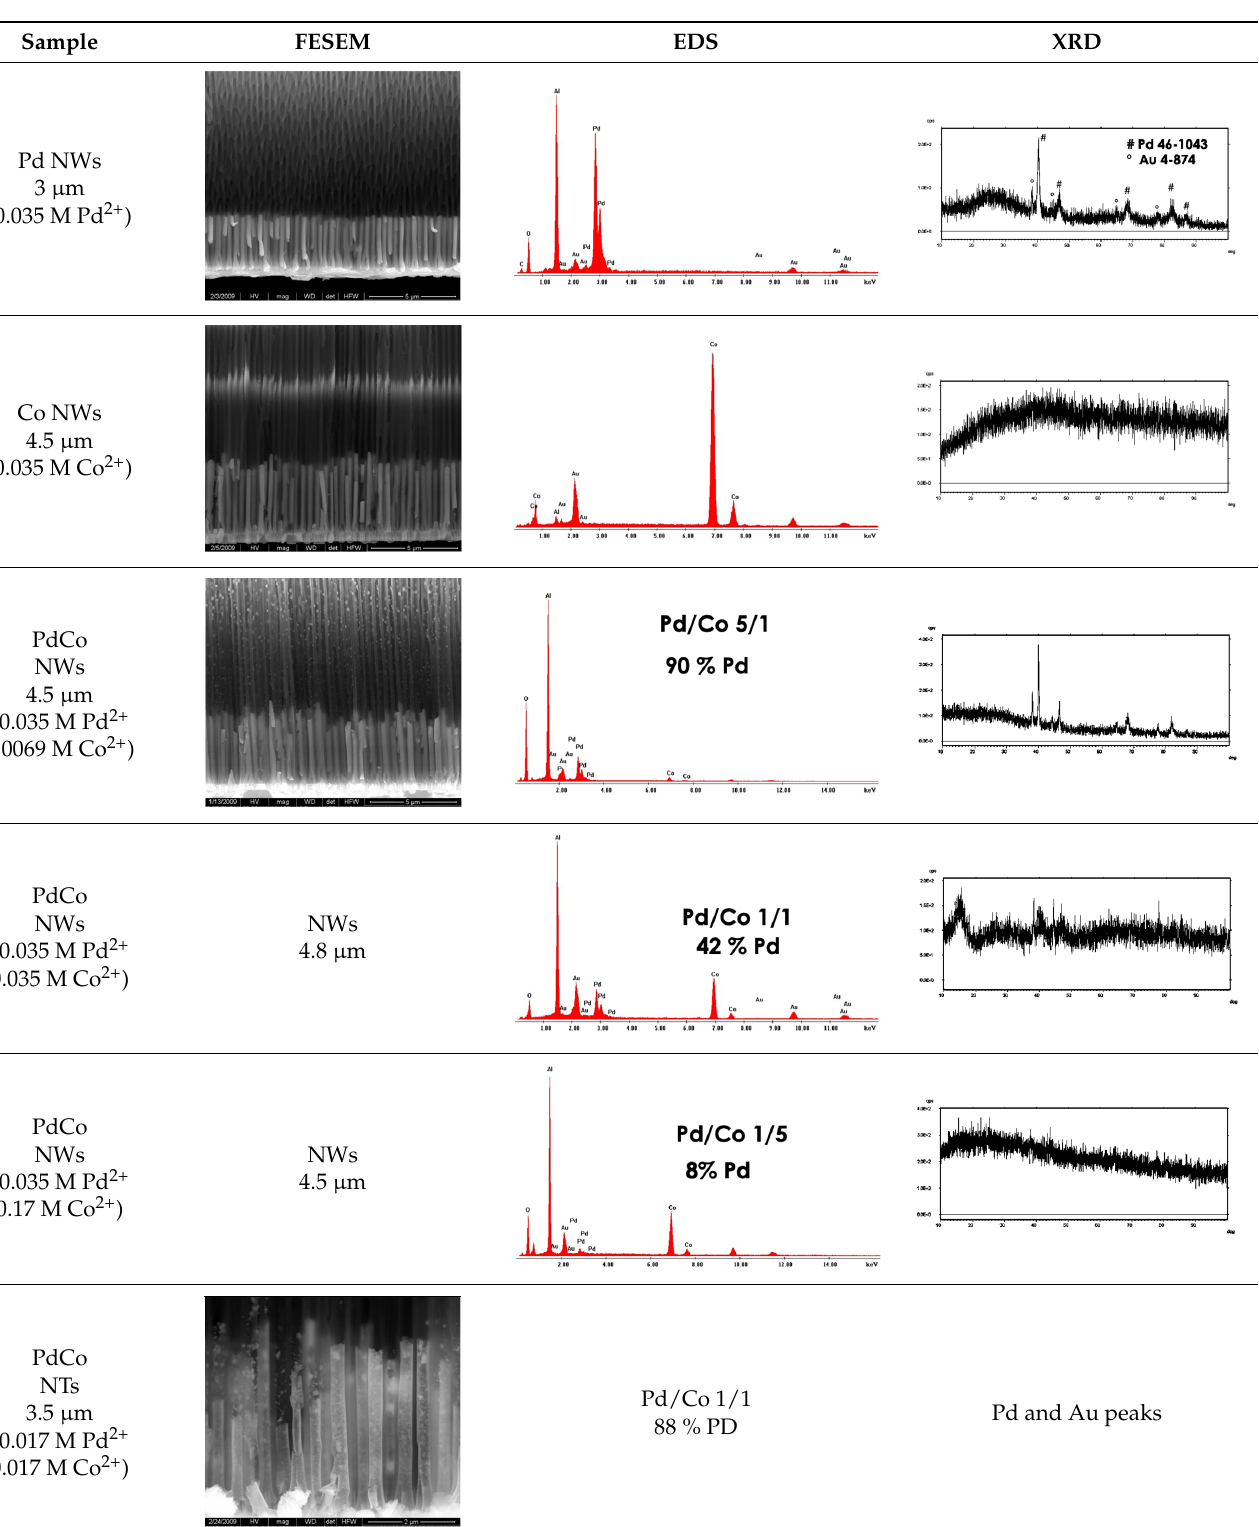
Table 3. FESEM (cross-sectional view), EDS and XRD results for nanostructured electrodes obtained at − 1 mA cm − 2 for 1 h. Additionally, the composition of electrodeposition bath and the nanostructure height was reported.